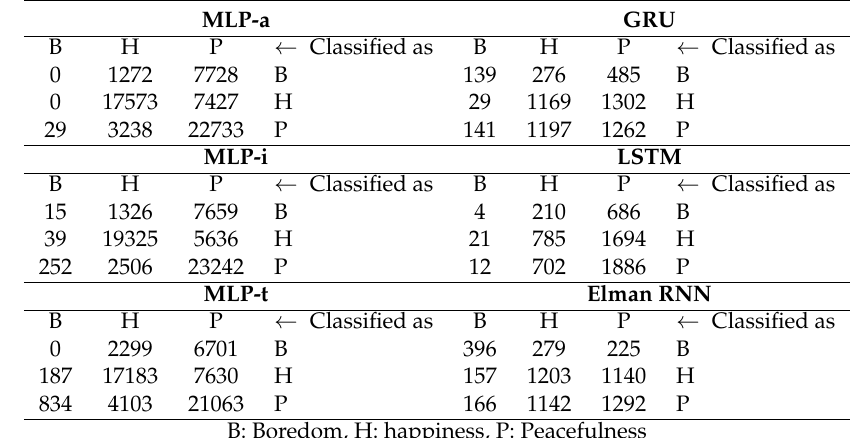
Table 12. Confusion matrix of the final test (MLP models—1000 iterations|RNN models— 100 iterations).